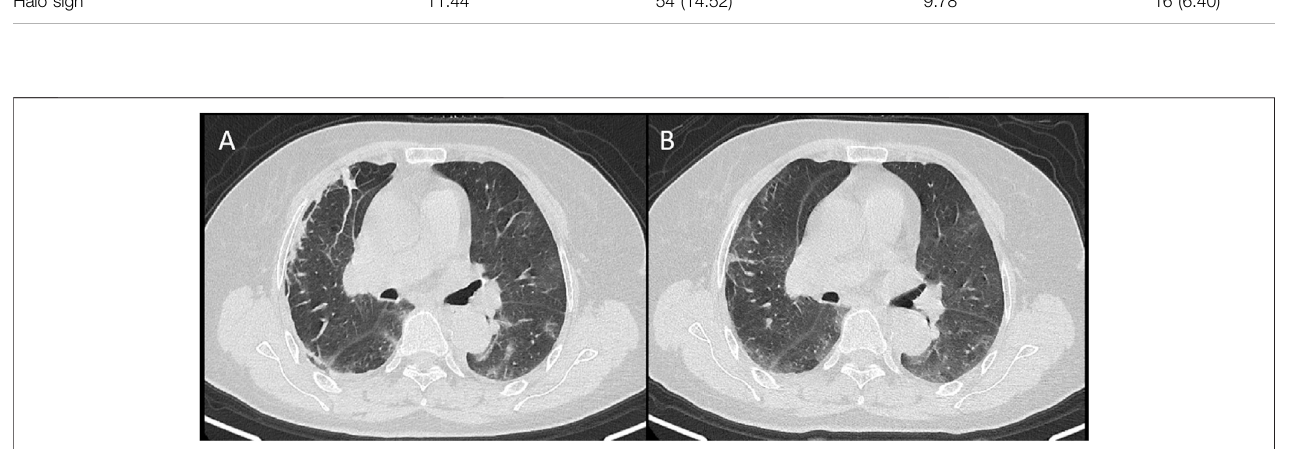
FIGURE 5 | A 68-year-old female showed lobular atelectasis in the subpleural area of the right upper lobe on day 3 from onset (A) and disappeared on day 6 (B)